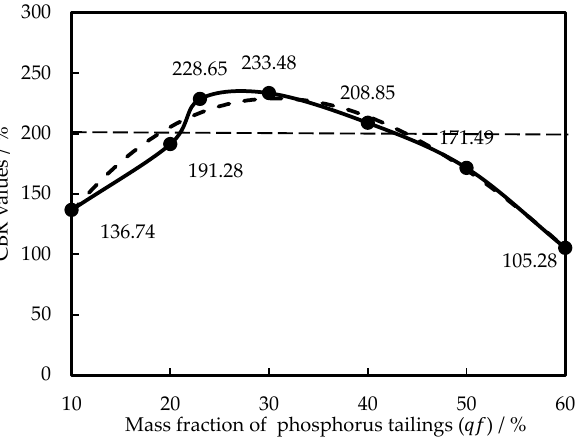
Figure 12. Value of mixture with different mass fractions of phosphorus tailing.